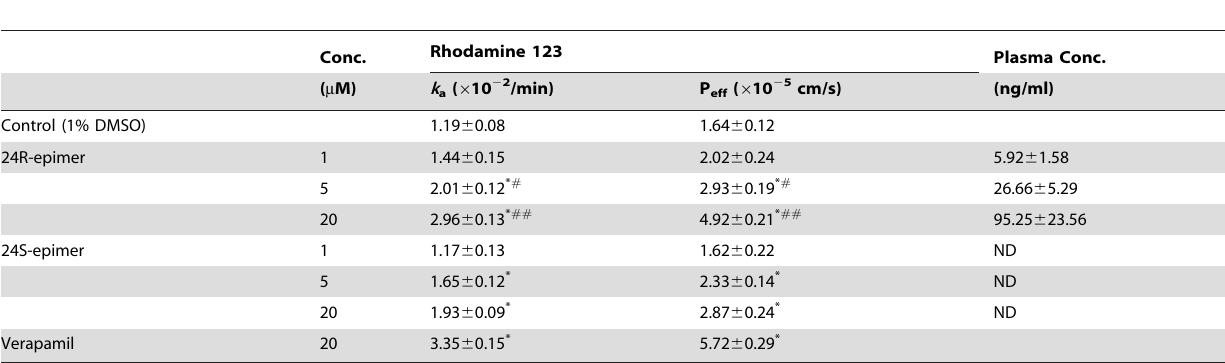
Table 4. Effects of 24R-epimer and 24S-epimer on absorption rate constant ( k a ), permeability (P eff ) of rhodamine 123 in the single- pass intestinal perfusion model in rats, and the plasma concentration of both epimers after perfusion for 2 h.